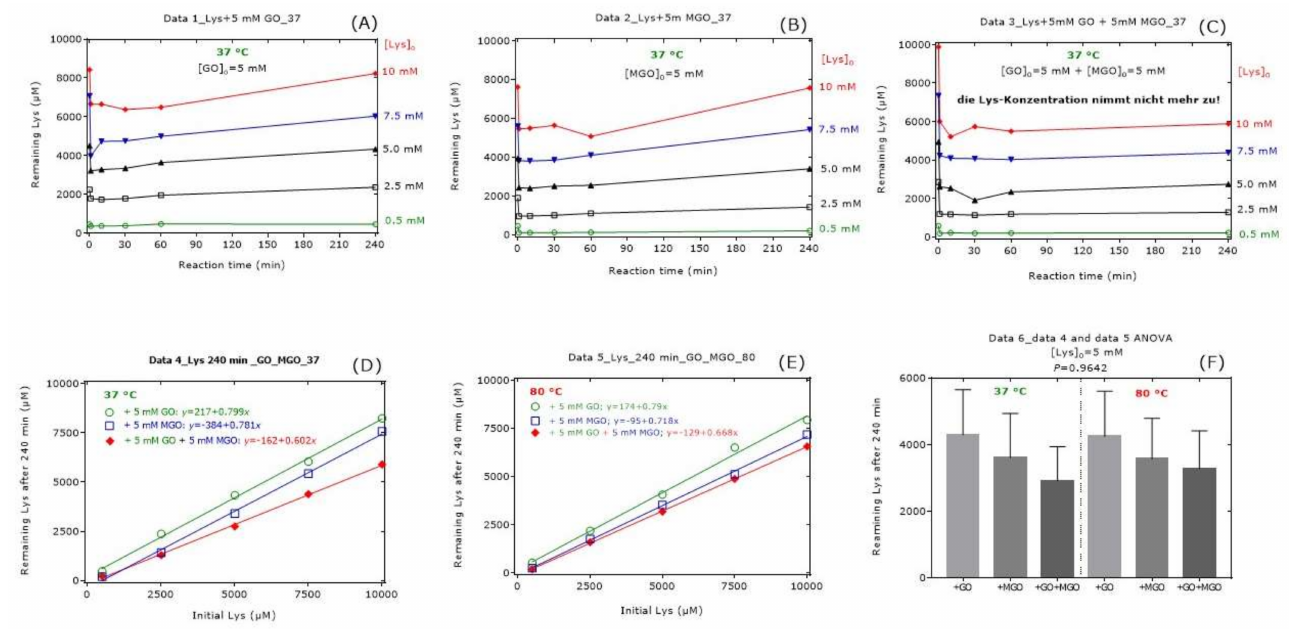
Figure 3. Remaining Lys concentration in reaction mixtures of Lys, GO and MGO incubated for 37 ◦ C and 80 ◦ C. All experiments were performed in independent triplicates. For the sake simplicity, only the mean values were plotted in ( A – E ). In ( F ), data are presented as mean with standard error of the mean. Linear regression analysis was performed between remaining Lys concentration ( y ) and initial Lys concentration ( x ). See also Tables